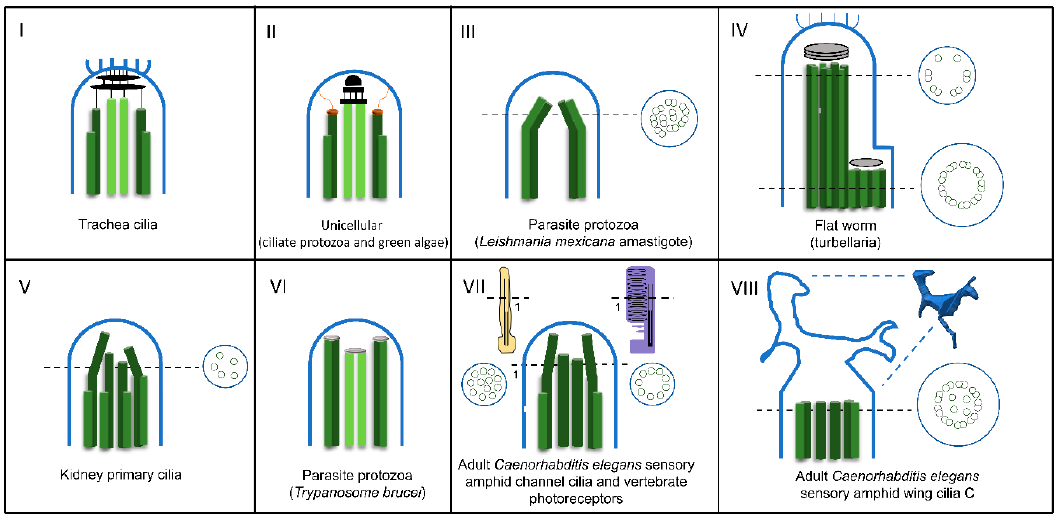
Figure 3. Diversity of cilia distal domain architectures. ( a ) Schematic representation of representative cilia tip structures. (I) In trachea cilia, the axoneme structure is (9+2) and at the tip the A-tubules and central pair are bound to a central cap that is attached to the ciliary crown, a structure constituted by a cluster of fibrils that project from the membrane to the outside of the cilia tip. (II) In the ciliate